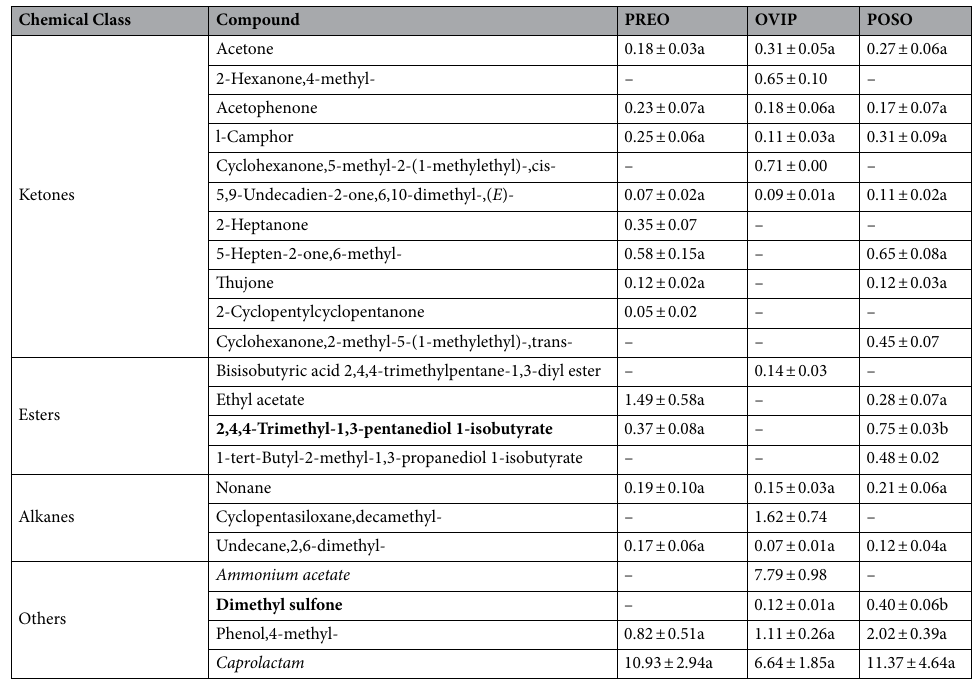
Table 1. The volatiles from fresh feces of Przewalski’s horse at the stages of PREO, OVIP, and POSO of Gasterophilus pecorum. PREO, OVIP, and POSO represent fresh feces at the stages of pre-oviposition, oviposition, and post-oviposition of Gasterophilus pecorum , respectively. The match values of all substances were greater than 700, and those less than 700 were uncertain compounds, which were not listed in this Table 1. *Volatiles written in italic font indicate those of the five most abundant substances between the fresh feces of different stages. **Data are mean (n = 3) ± SE. Different letters indicate significant differences at P < 0.05. ***Volatiles written in bold font indicate those with significant differences between the fresh feces of different